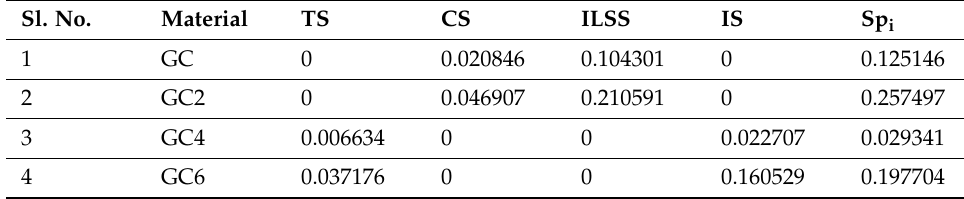
Table 6. Weighted sum of PDA.